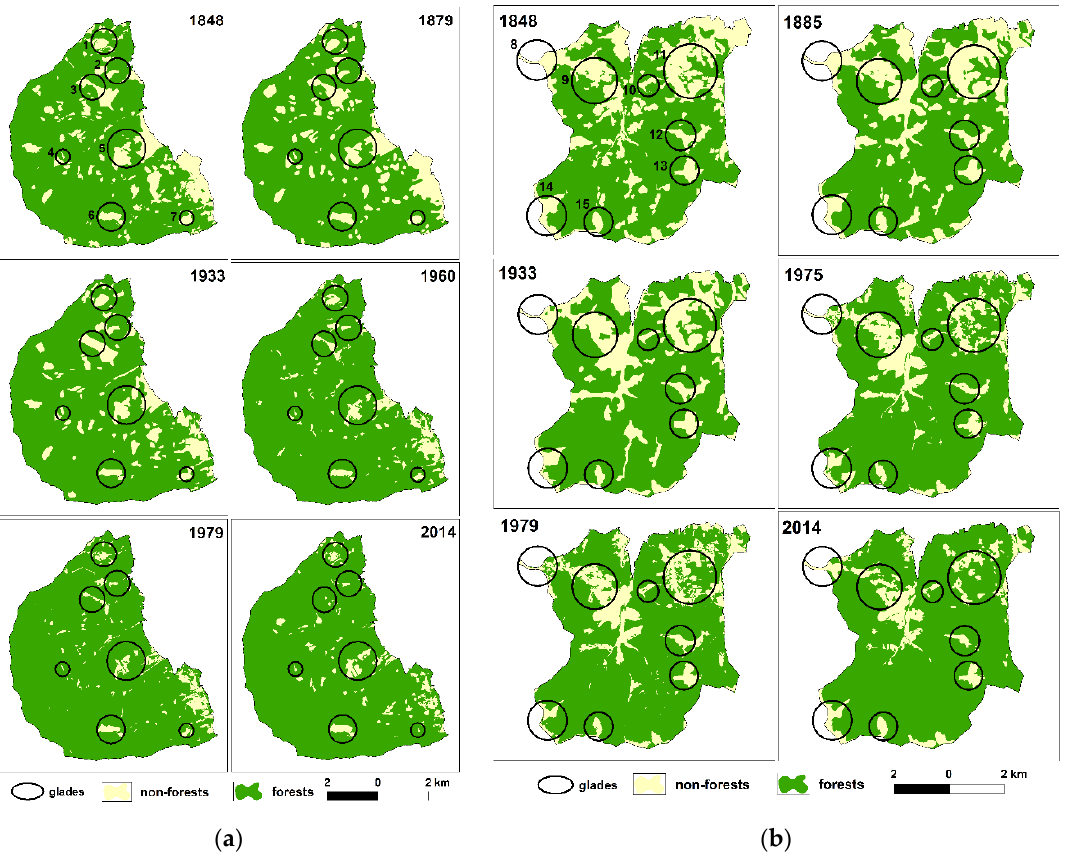
Figure 3. Changes in non-forest areas: ( a ) the Silesian Beskids ( b ) the Żywiec -Kysuce Beskids. 1 – 15 — numbers of glades — see Table 1 and Figure 4.